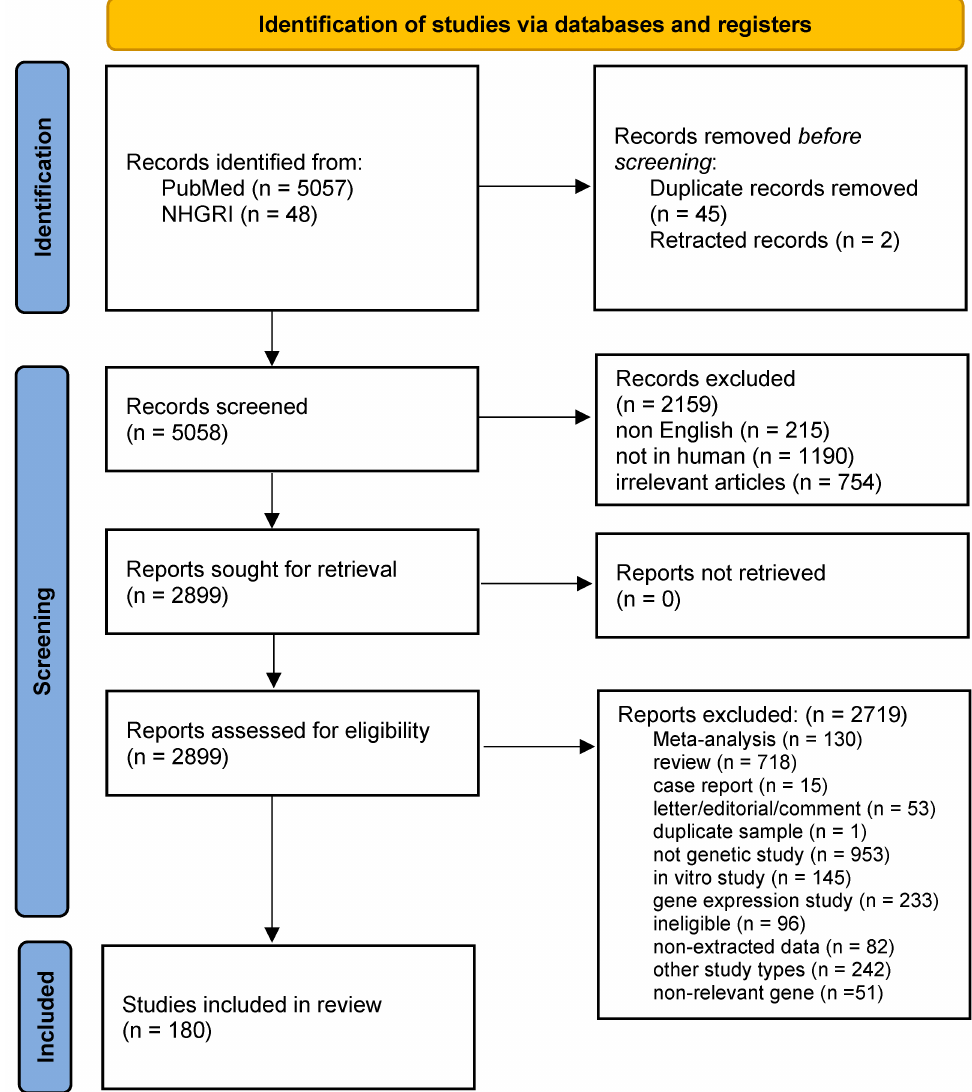
Figure 2. Flowchart of retrieved articles with specification of the reasons for exclusion.